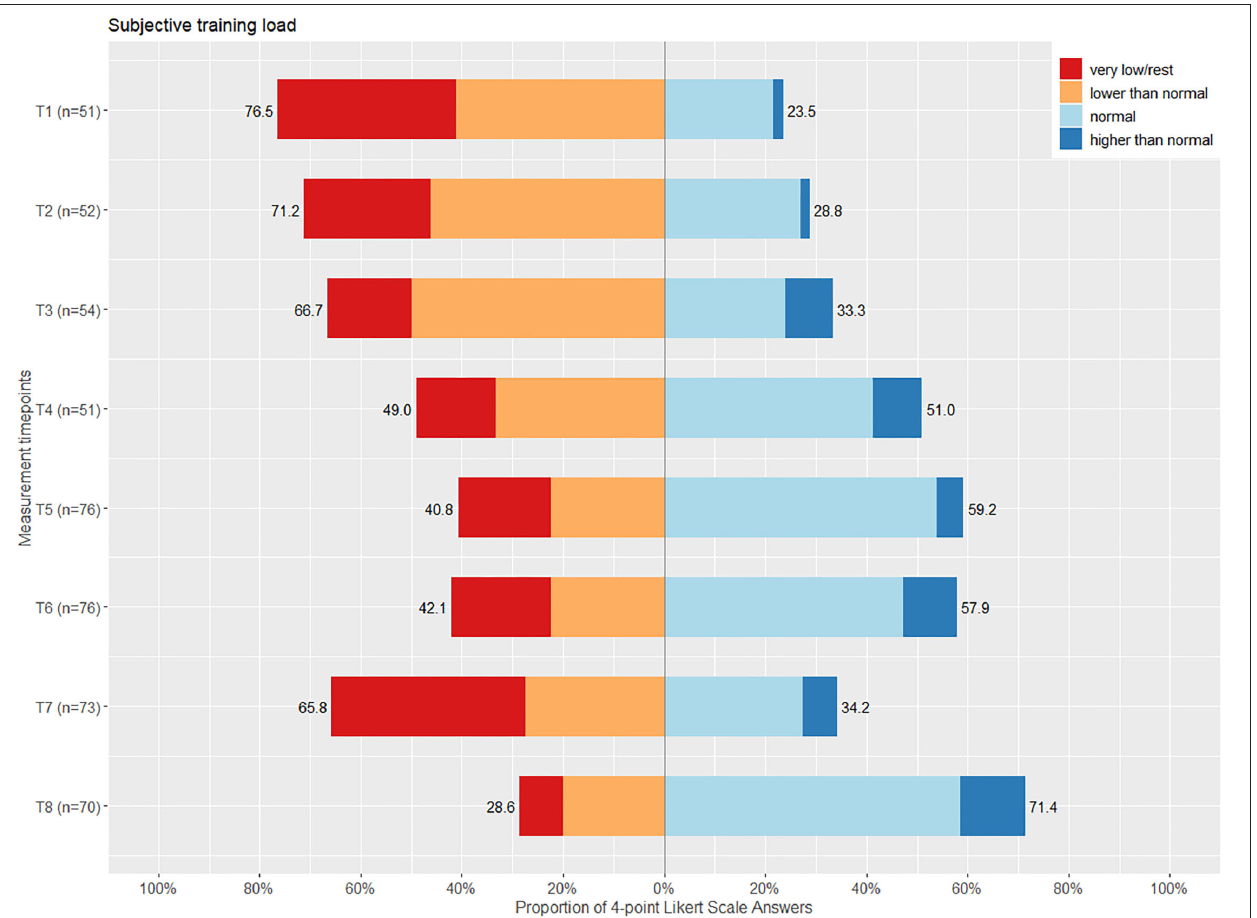
FIGURE 1 | A bar chart of the 4-point Likert scale asking for the subjective training load in para-athletes, with the answers ranging from very low/rest to higher than normal with the according sum of percentages of positive or negative answers given per measurement time point